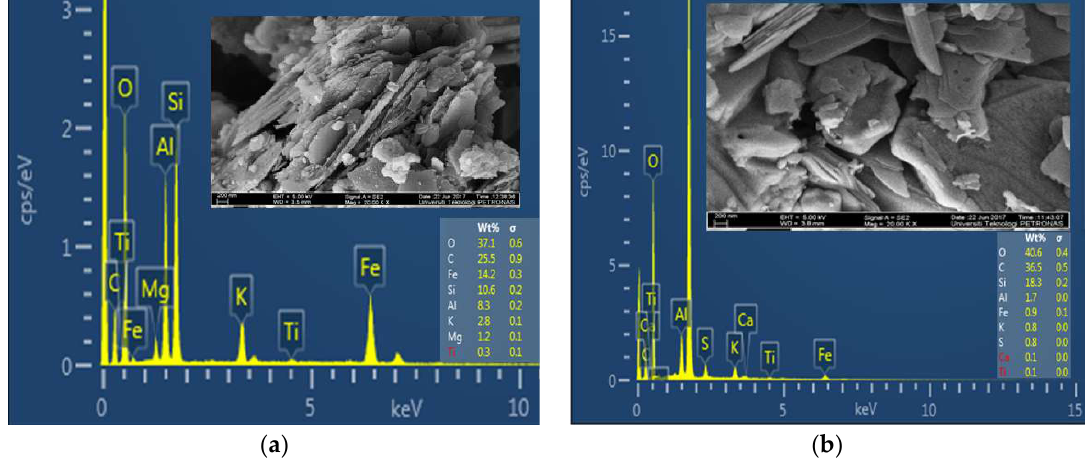
Figure 5. The Energy-Dispersive X-Ray (EDX) spectra of ( a ) BG-2 and ( b ) KH-2 shales with a corresponding miniature FE-SEM